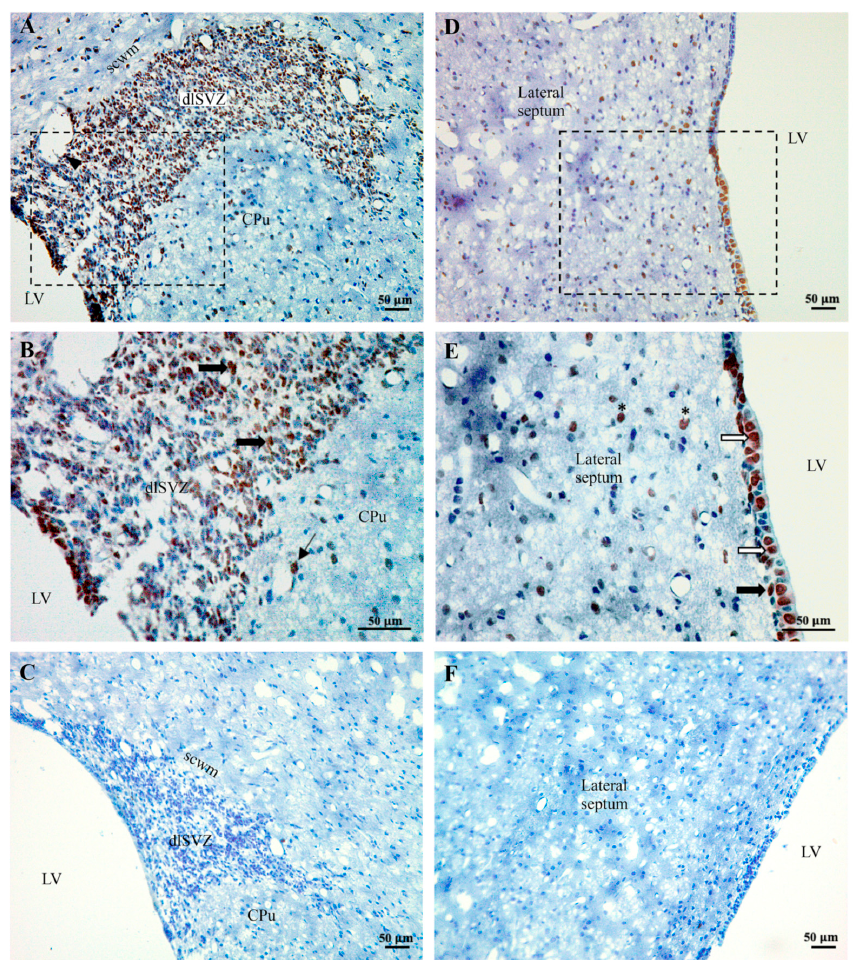
Figure 6. Brightfield images showing the location of subcutaneously injected cultured adipose-derived-mesenchymal stem cells (AD-MSCs) in the rat brain. ( A , B ) In the dorsolateral subventricular zone (dlSVZ) and caudate-putamen (CPu), bromodeoyuridine (BrdU)-labeled AD-MSCs were immunostained with diaminobenzidine yielding black/brown cells. They are indicated with either a single thick black arrow (dlSVZ) or a thin black arrow (CPu). The boxed area in ( A ) is shown at higher magnification in ( B ). The black arrowhead in ( A ) indicates a blood vessel. ( D , E ) BrdU-labeled AD-MSCs were also evident in the ependymal layer and subventricular zone (SVZ) of the lateral ventricle (LV) and the lateral septum. The boxed area in ( D ) is shown at higher magnification in ( E ). In ( E ), BrdU-labeled AD-MSCs are indicated by a white single arrow in the ependymal layer, and by a black arrow in the subependymal layer, of the SVZ, and by an * in the lateral septum. Note that there were numerous labeled AD-MSCs in the dlSVZ and the ependymal layer and fewer labeled AD-MSCs in the CPu and lateral septum. ( C , F ) Negative control sections showing no BrdU-labeled AD-MSCs. All sections are from a postnatal day (PN) 17 rat that was subcutaneously injected with cultured BrdU-labeled AD-MSCs on PN14 and PN16, following perinatal hypoxia-ischemia (HI) at PN7. All sections were counterstained with thionin (blue). scwm, subcortical white matter.